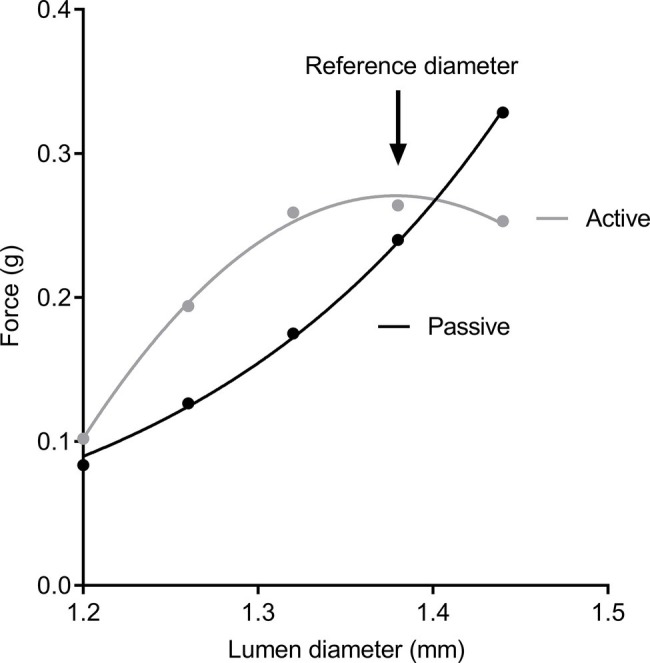
Diameter-force curves. Passive force (black circles) and active force (gray circles) after stimulation to KCl solution. Peak contraction was used to establish a reference diameter for dose-response curves.